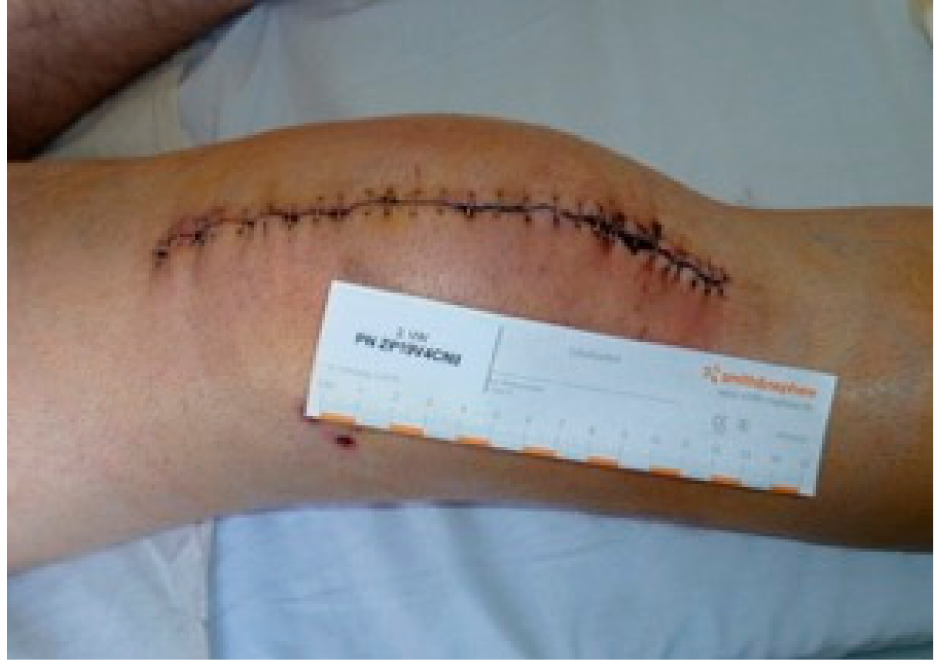
Figure 5. Control group: second dressing change (fifth postoperative